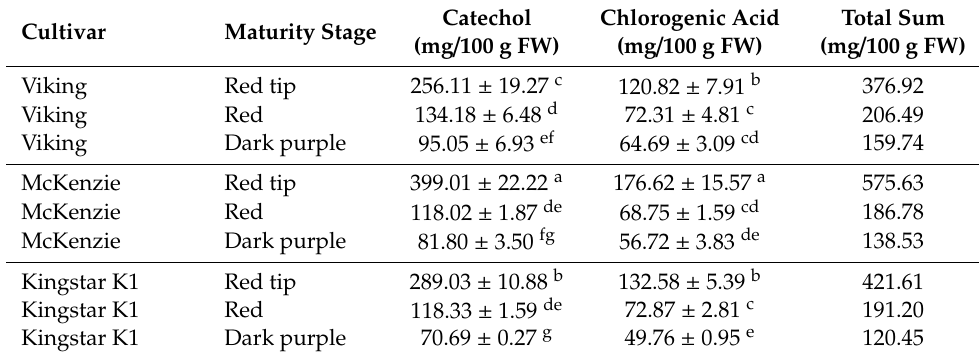
Table 4. Polyphenol contents of Aronia melanocarpa fruits at di ff erent maturity